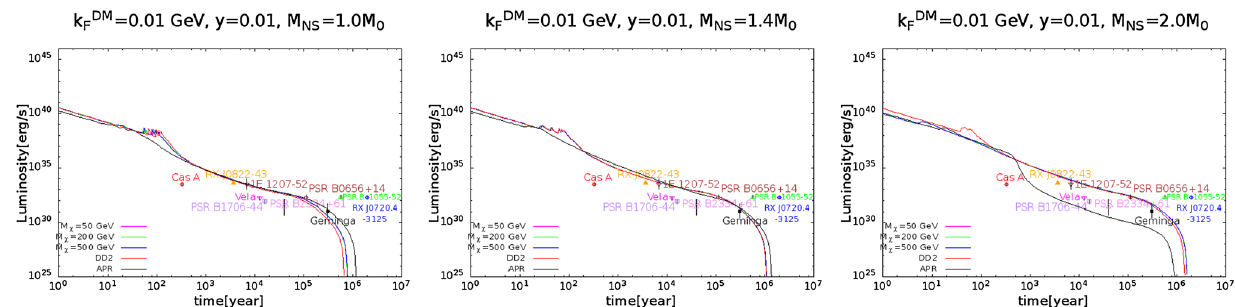
Fig. 10 Variation of luminosity with time for three differently cho- sen NS masses M NS = 1 . 0 M (cid:8) (left panel), M NS = 1 . 4 M (cid:8) (mid- dle panel), M NS = 2 . 0 M (cid:8) (right panel) with varying M χ and fixed = 0 . 01GeV in each panel. The theoretical calculations are com- k DM F